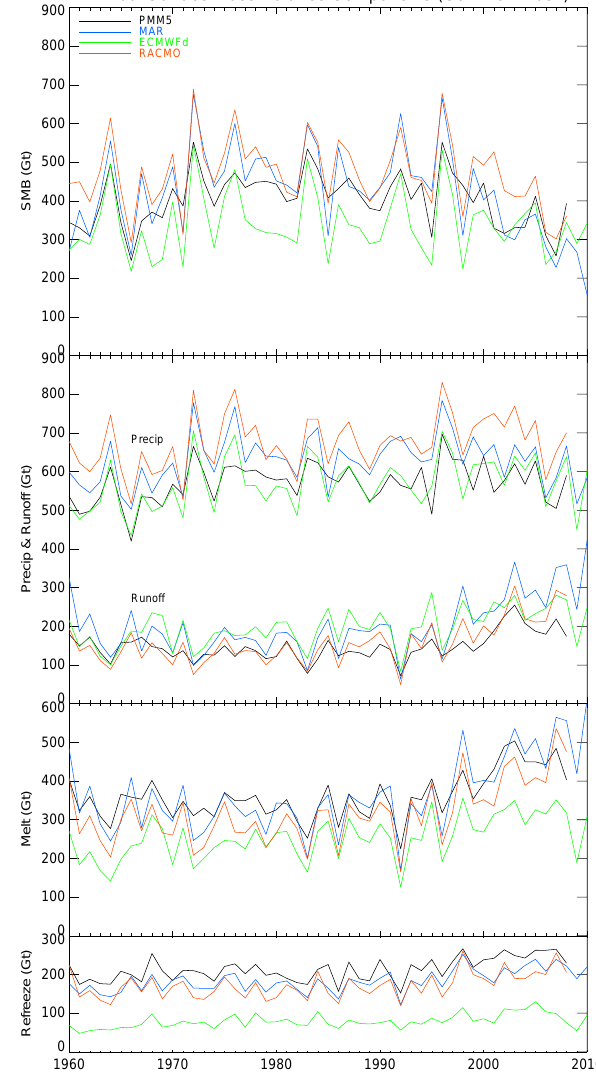
Fig. 4. Time series of SMB and components on the common